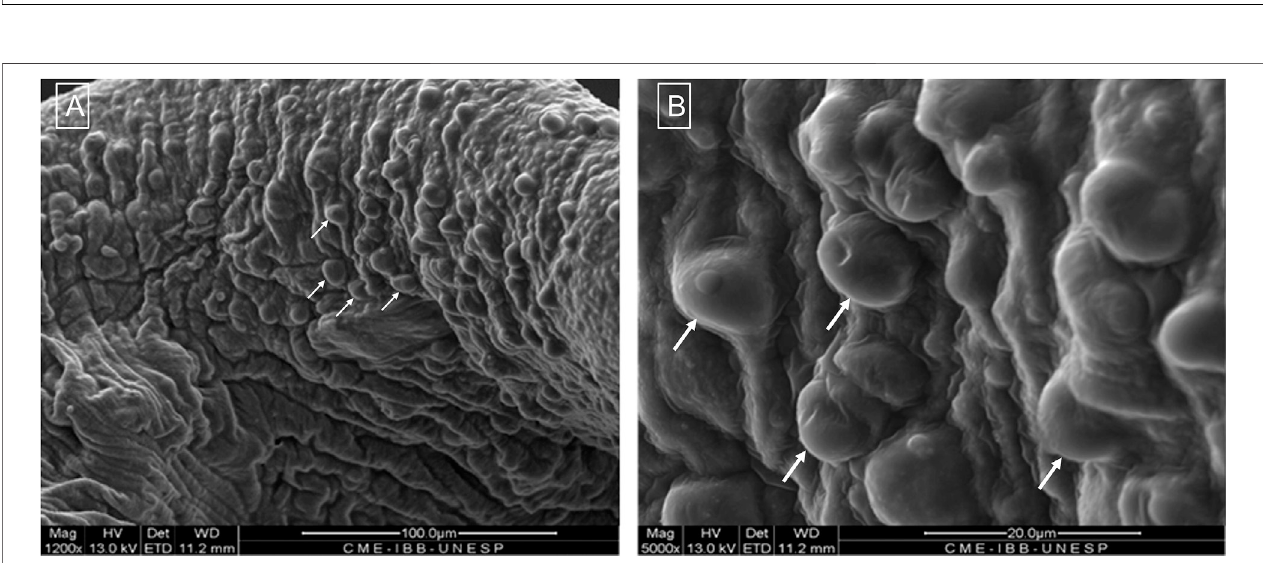
FIGURE 3 | Morphological structure by SEM showing the capsule surface and presence of cells (arrows) at magni fi cation of 1,200x (A) and 5,000x (B) .